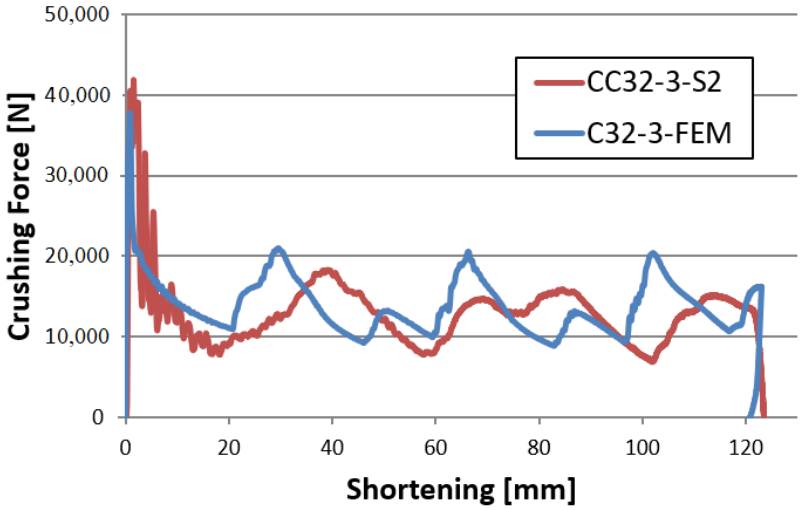
Figure 9. The force-shortening curve for an empty model with a concave crush